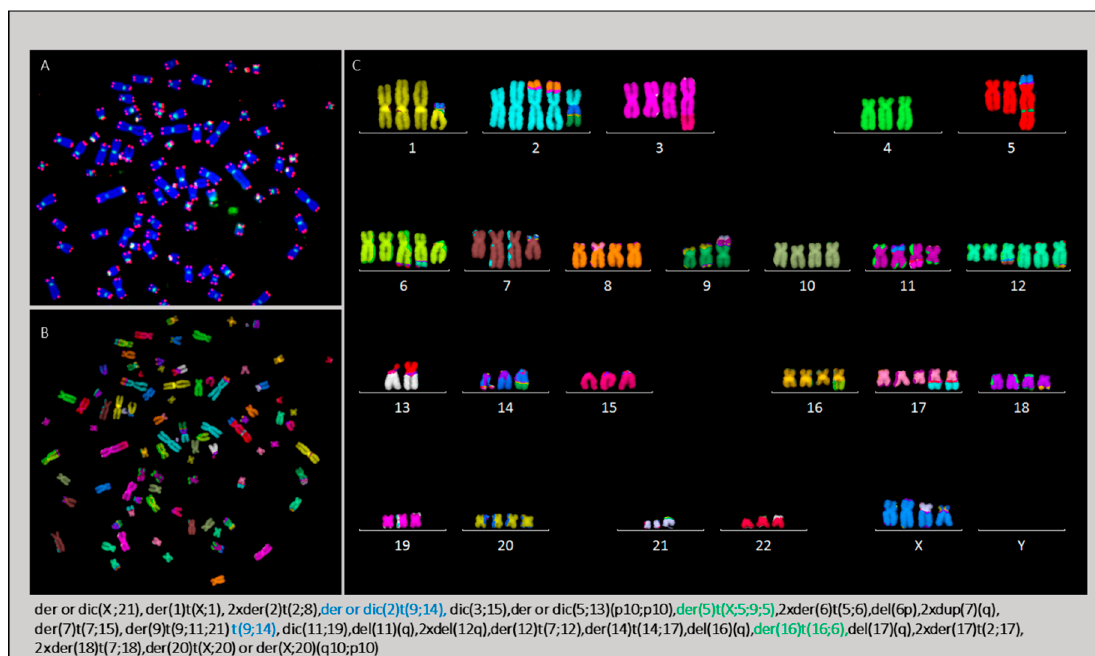
Figure 12. Cytogenetic characterization of HL cells recovered from a mouse liver by ( A ) telomere and centromere staining followed by ( B ) M-FISH. This approach allowed a detailed classification of chromosomes ( C ). Clonal chromosomal aberrations are listed and specific aberrations compared to those of the L428 cell line and L428-c subline are highlighted in green and blue, respectively, at the bottom of the figure (63× magnification).